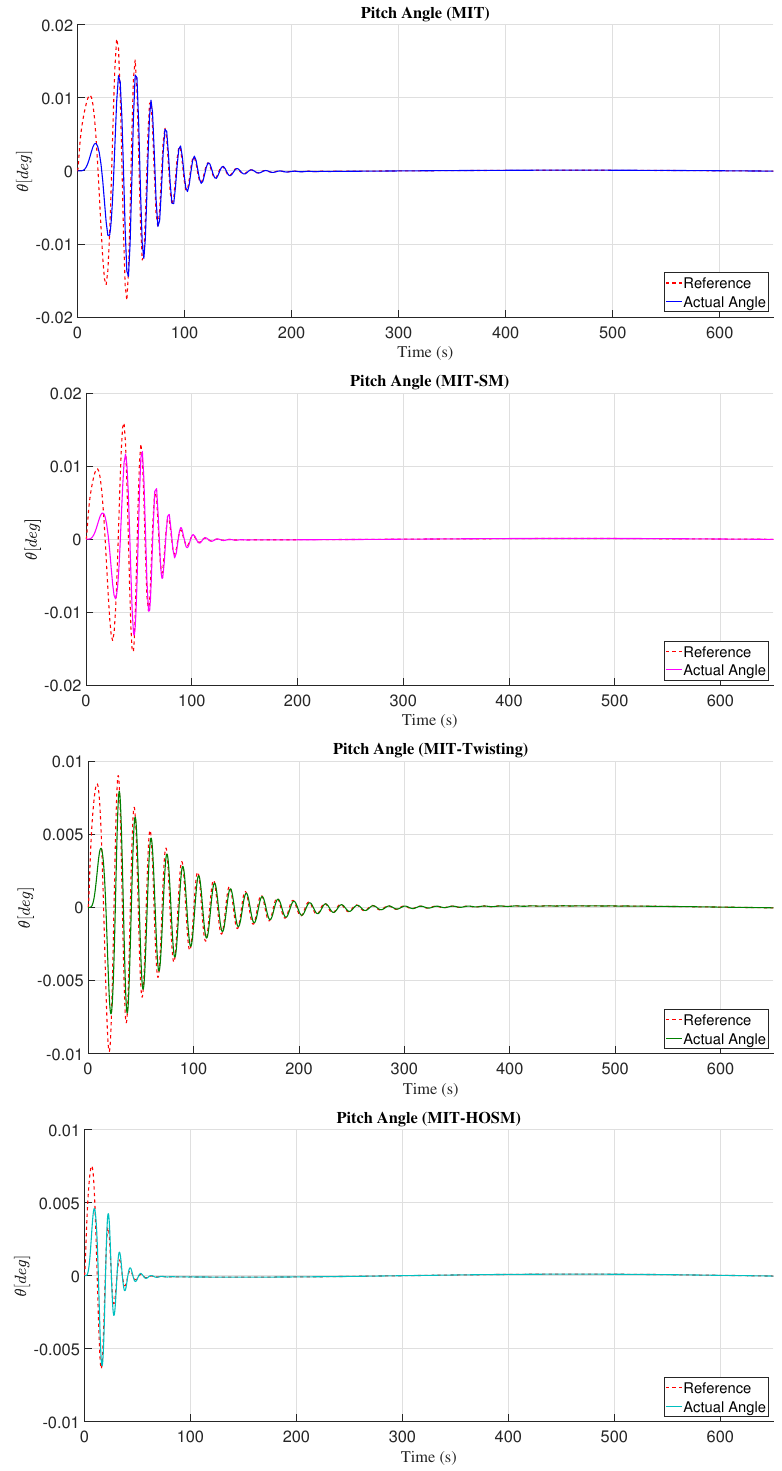
Figure 8. Pitch angle